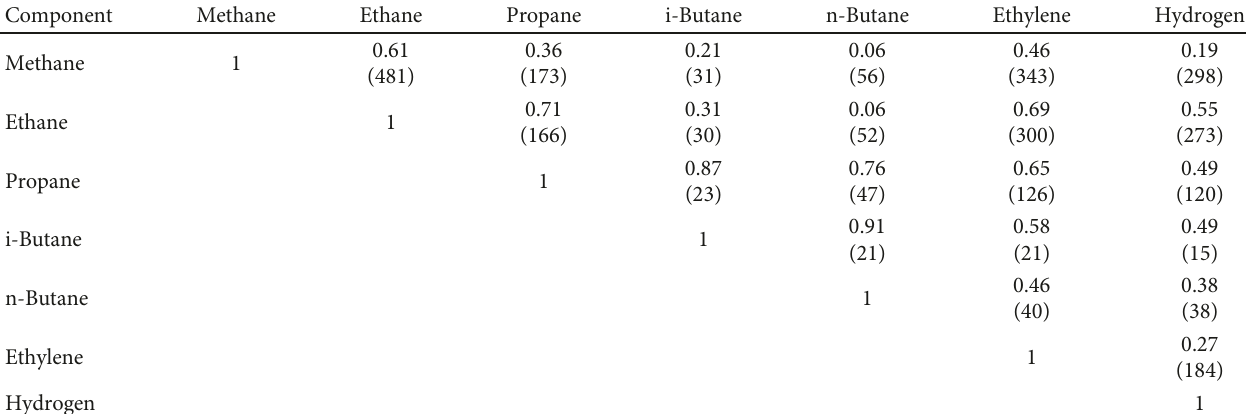
Table 7: Pearson correlation coe ffi cients of hydrocarbons and hydrogen concentrations in analyzed soil gas samples. Component